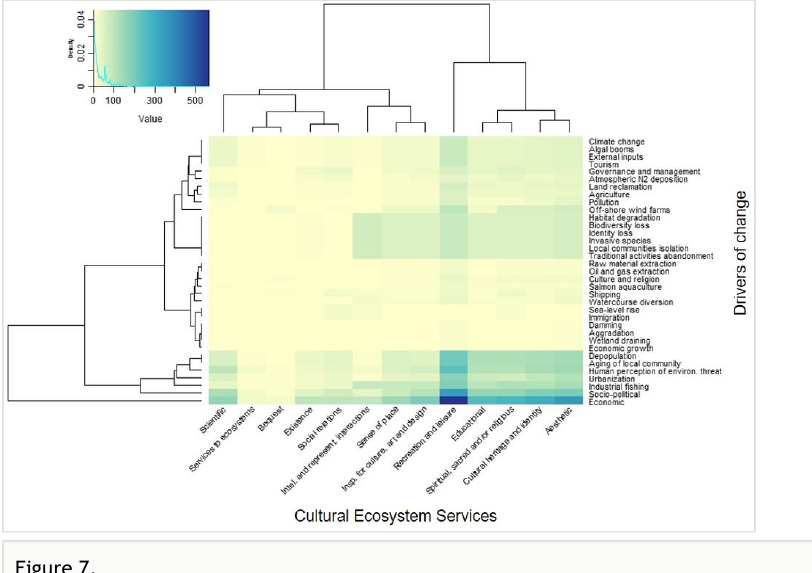
Drivers of change a ff ecting marine and coastal CES classes. Dendograms represent similar drivers grouped by hierarchical clustering on the Euclidean distance between the rows and columns of the matrix, according to the number of links found in the literature